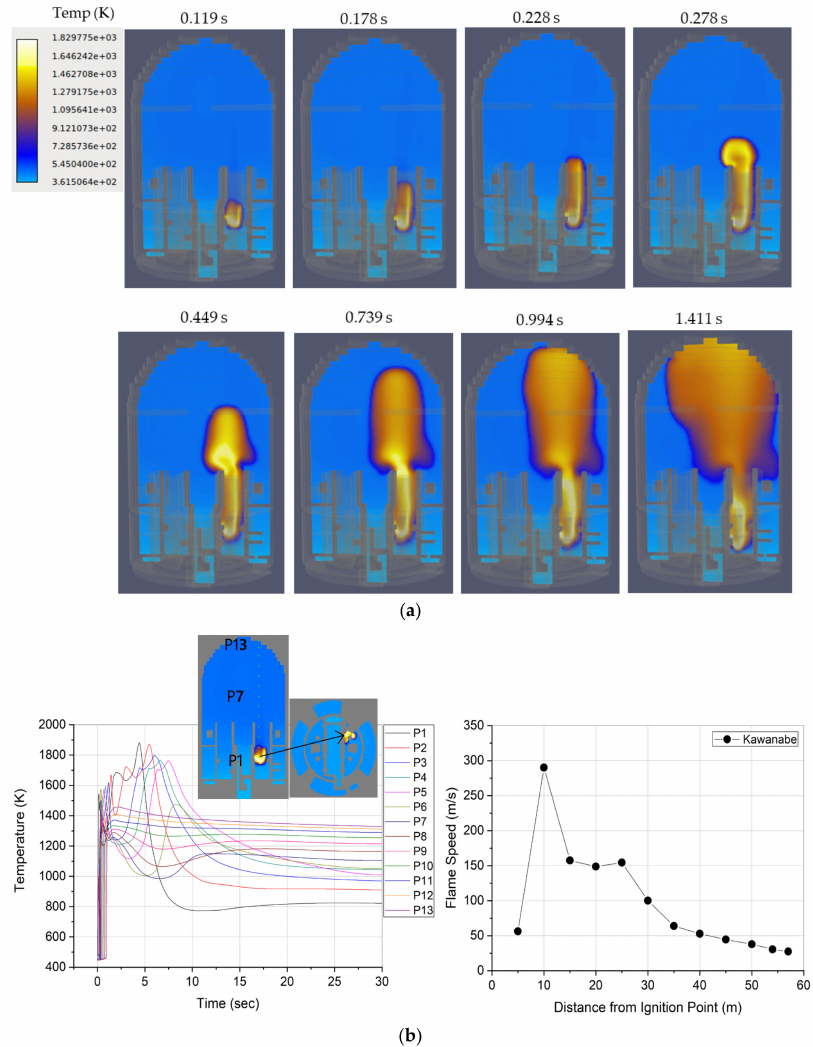
Figure 9. Calculated temperature for the hydrogen flame acceleration by COM3D. ( a ) Temperature distribution as time passes. ( b ) Temperature behaviors and flame speeds from P1 to